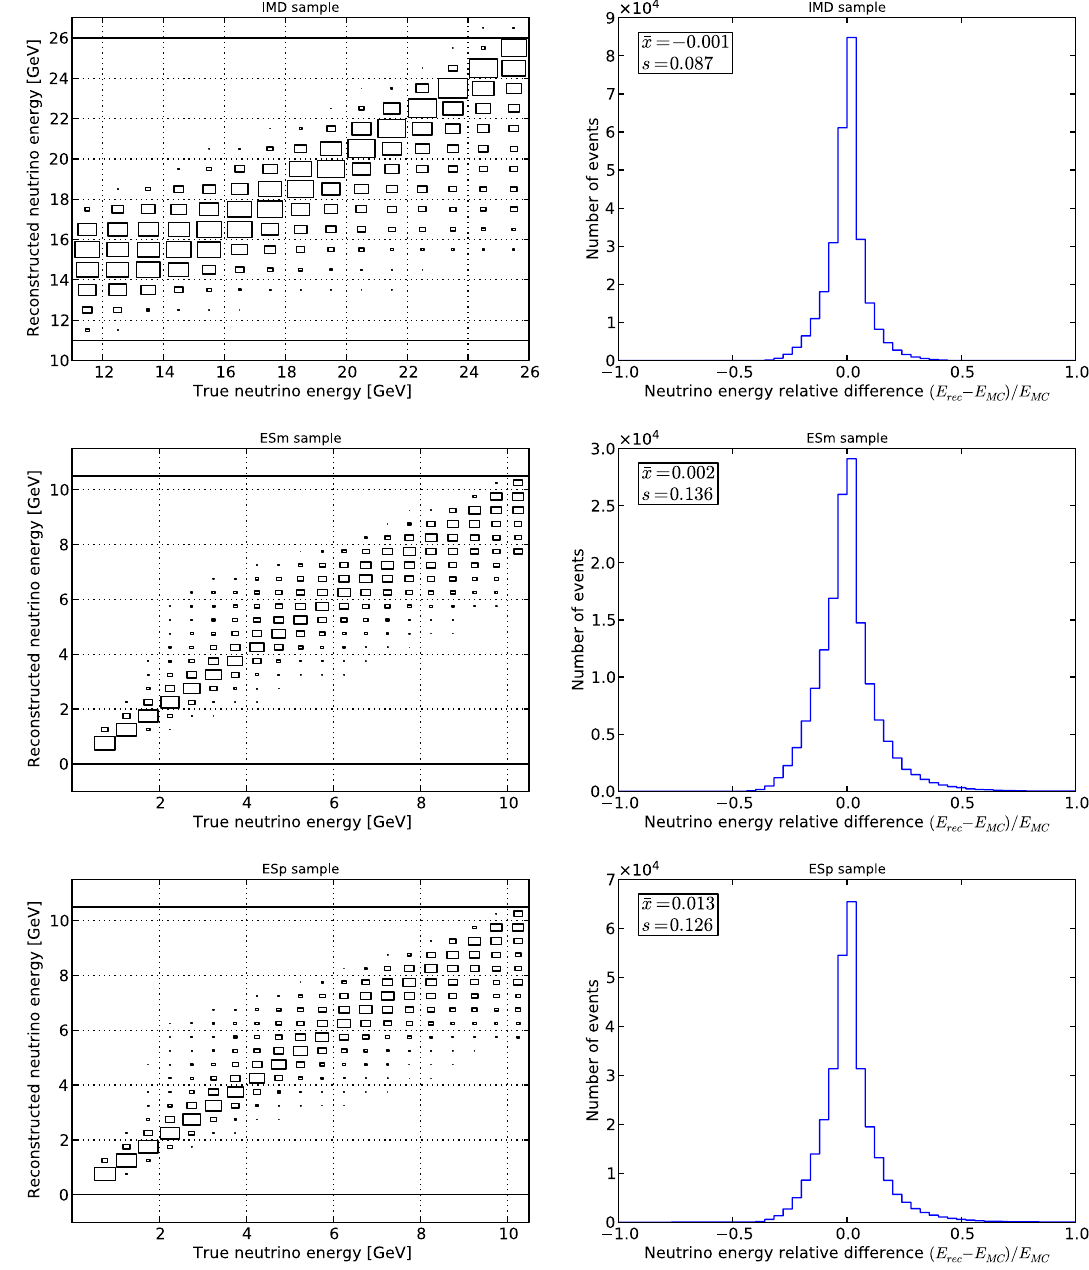
FIG. 15. Improved reconstruction of the neutrino energy. Left—migration matrix (the sum over each column is normalized to unity). The overflow and underflow bins are separated with horizontal lines. Right—relative difference ð E rec (cid:5) (cid:1) E true (cid:5) Þ =E true (cid:5) for the respective leptonic event sample (background excluded). Top—IMD sample; middle— ES (cid:1) sample (10 GeV NF); bottom— ES þ sample (10 GeV